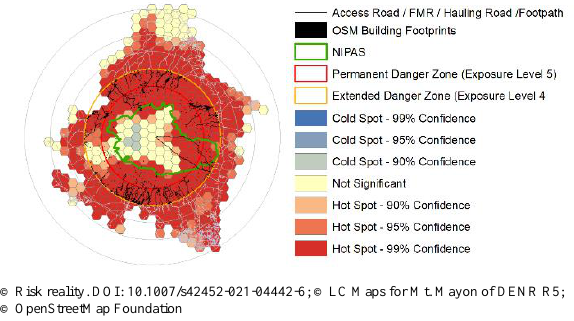
Figure 11. Risk reality vs Road and Building